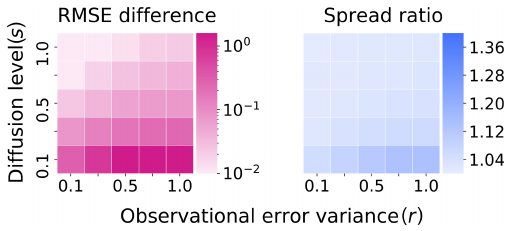
Figure 8. Truth: Taylor (cid:49) t = 10 − 3 . Ensemble: Euler–Maruyama (cid:49) e = 10 − 2 . Difference in RMSE/ratio of spread with benchmark Fig.